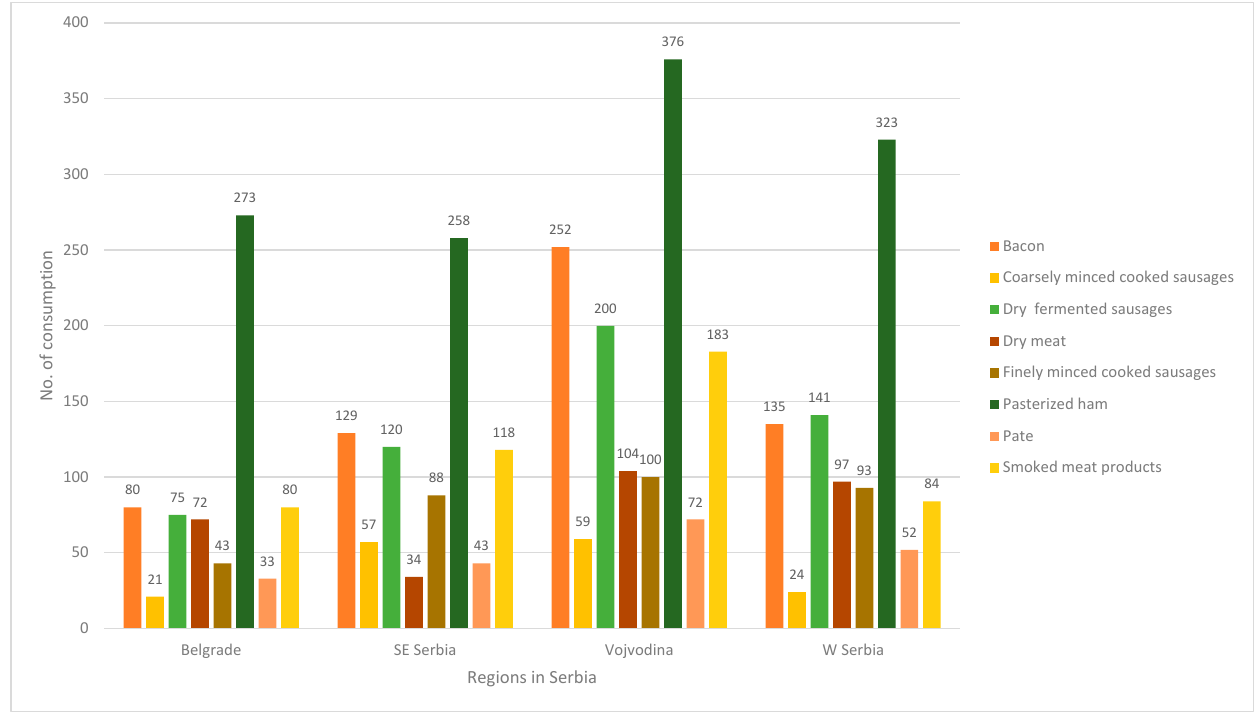
Figure 1. Frequency of consumption of meat products in four regions in Serbia.